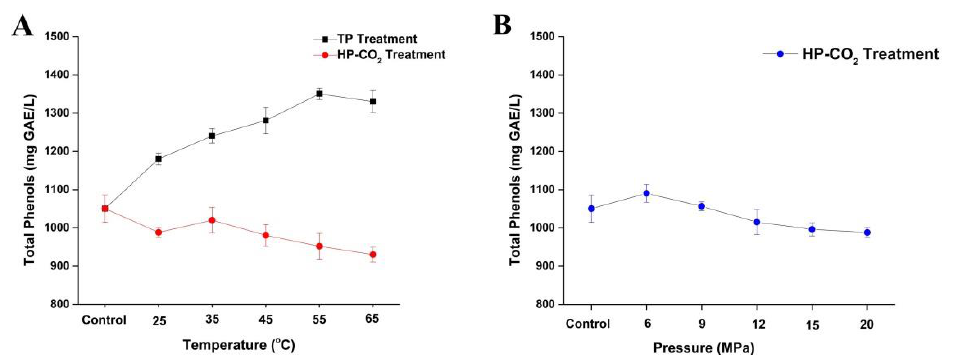
Figure 4. Changes of total polyphenol content (TPC) in apple juice under thermal (25–65 °C) and HP-CO 2 (25–65 °C for 20 MPa) treatment for 20 min ( A ) and HP-CO 2 treatment at different pressures (6–20 MPa, 30 °C) for 20 min ( B ). Data presented as the mean ± SD (standard deviation). GAE stands for Gallic acid equivalent.